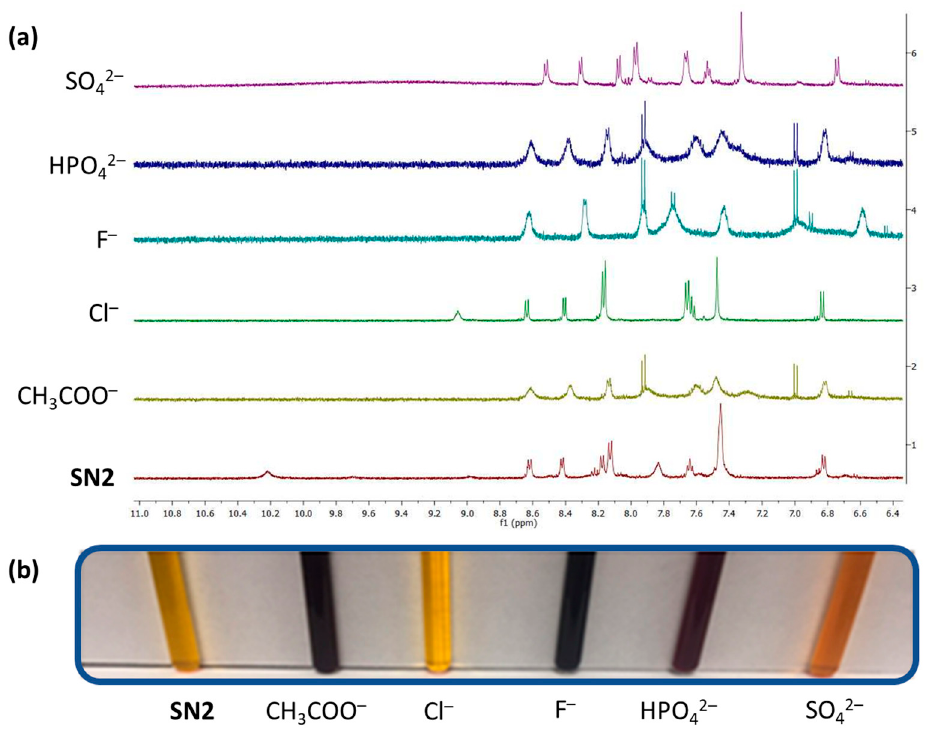
Figure 5. ( a ) 1 H NMR stackplot of SN2 with various anions (30 equivalents) in 0.5% H 2 O in DMSO-d 6 at 298 K. ( b ) The corresponding colour changes upon anion addition.